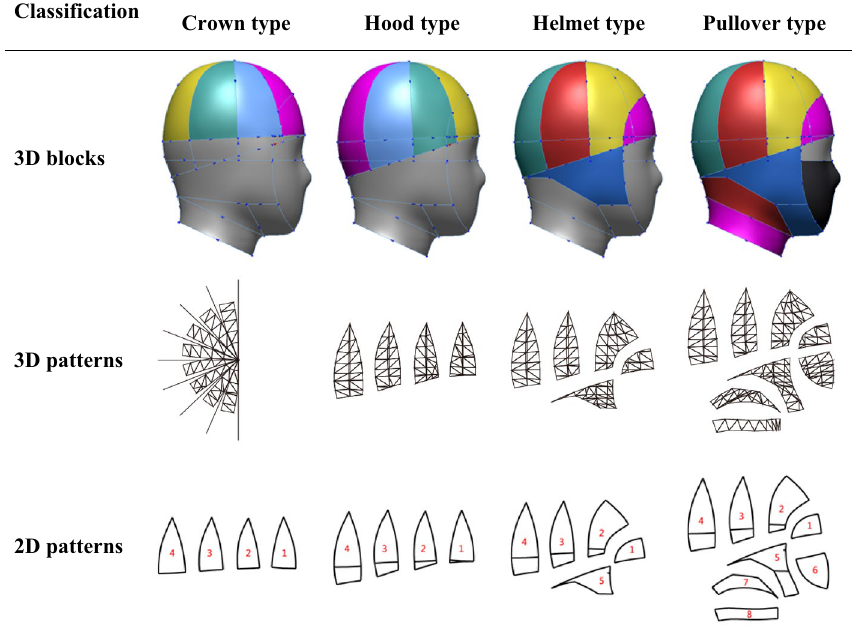
Table 12 Results of prototype pattern development by hat